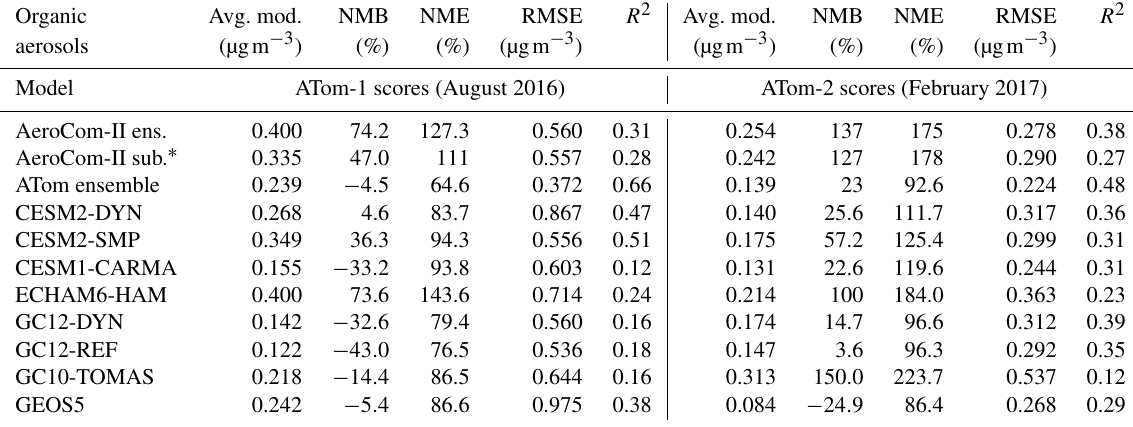
Table 2. Comparison of observed and simulated OA concentrations along ATom-1 and ATom-2 flights for eight global model simulations and their ensemble. The results of the model ensemble are also indicated. The statistical indicators are calculated as the normalized mean bias (M i − O i )/ (cid:80) O i , normalized mean error (NME; %) = 100 × (cid:80) (NMB; %) = 100 × (cid:80) i i